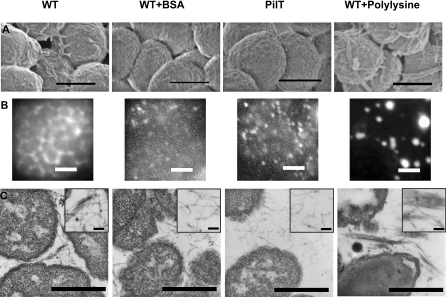
Tfp from WT MS11 and MS11PilT in Different States of BundlingWT: MS11 not exposed to BSA; WT + BSA: MS11 incubated with BSA; PilT: MS11PilT not exposed to BSA; WT + polylysine: MS11 incubated with polylysine.(A) SEM micrographs. Scale bar = 500 nm.(B) Fluorescent images of microcolonies immunostained with monoclonal anti-Tfp antibody (anti-SM1). Scale bar = 2 μm.(C) Thin-section EM image of Tfp and Tfp bundles. Insert in each panel represents a higher magnification image of representative Tfp in the sample. Note the bundles in the WT and WT+polylysine samples that are not present in the WT+BSA and pilT samples. Scale bar = 500nm. Scale bar = 50 nm in the inserts.